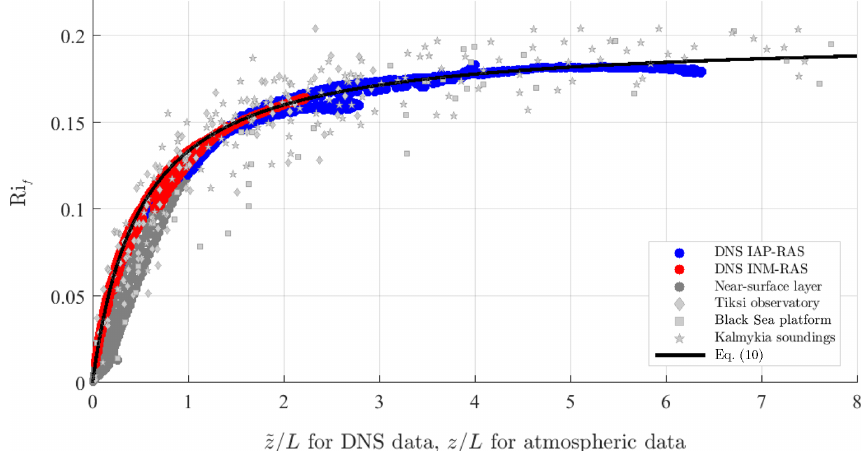
Figure 2. Flux Richardson number, Ri f , in stable stratification versus e z/L in Couette flow or versus z/L in the atmospheric surface layer. Empirical data used for the calibration are obtained in two series of DNS runs employing INM-RAS code (red dots) and IAP-RAS code (blue dots). Atmospheric data are taken from Arctic coastal observatory Tiksi (light-grey diamonds), Black Sea offshore platform (light- grey squares), and acoustic soundings in Kalmykia steppe (light-grey stars). Dark-grey dots belong to the very narrow near-surface layer: 0 < e z < 50 ν/τ 1 / 2 . The solid black line shows Eq. (10) with the conventional value for the von Kármán constant, k = 0 . 4, and new empirical value of R ∞ = 0 . 2 just obtained from the best fit of Eq. (10) to DNS data from elsewhere beyond the layer 0 < e z < 50 ν/τ 1 / 2 , where molecular transports are significant and Eq. (10) is not necessarily